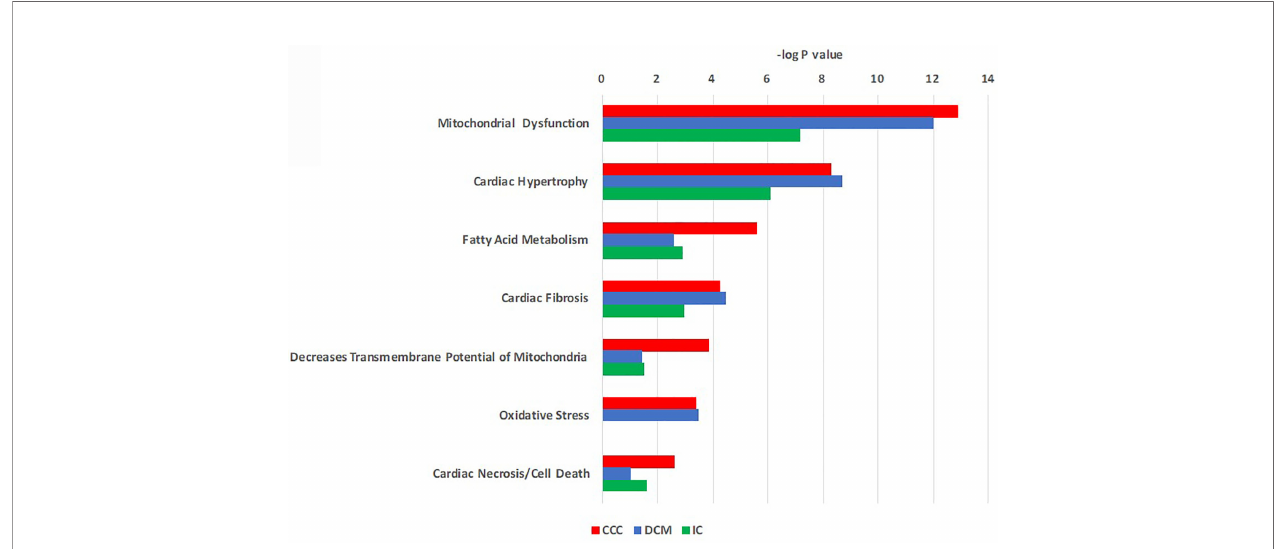
FIGURE 2 | Toxicity function pathways analysis of differentially expressed proteins in CCC, DCM and IC myocardium. Proteins differentially expressed in heart tissue were analyzed using Ingenuity Pathways Analysis ® (Qiagen) using the tox-list function, which classi fi es gene or protein sets into pathological/toxicological pathways. Bars indicate the – log p value for a given pathway or process.